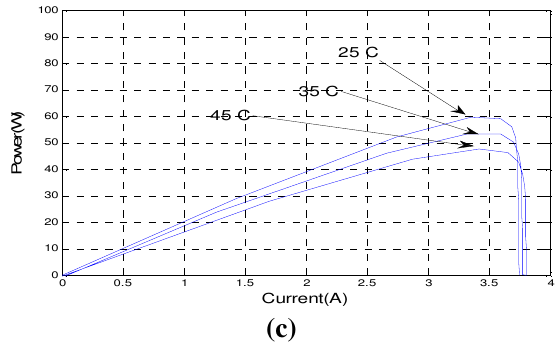
Fig. 14. (a) P-V, (b) I-V and (c) P-I characteristics at Fig. 15. (a) P-V, (b) I-V and (c) P-I characteristics at S=1000W/m2.